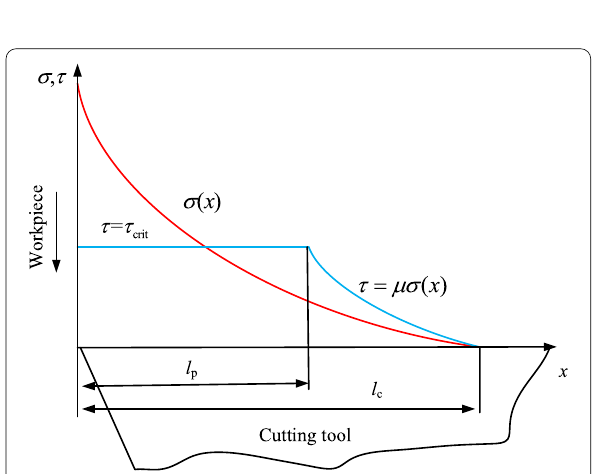
Figure 9 Stress distribution of normal and friction stresses on rake